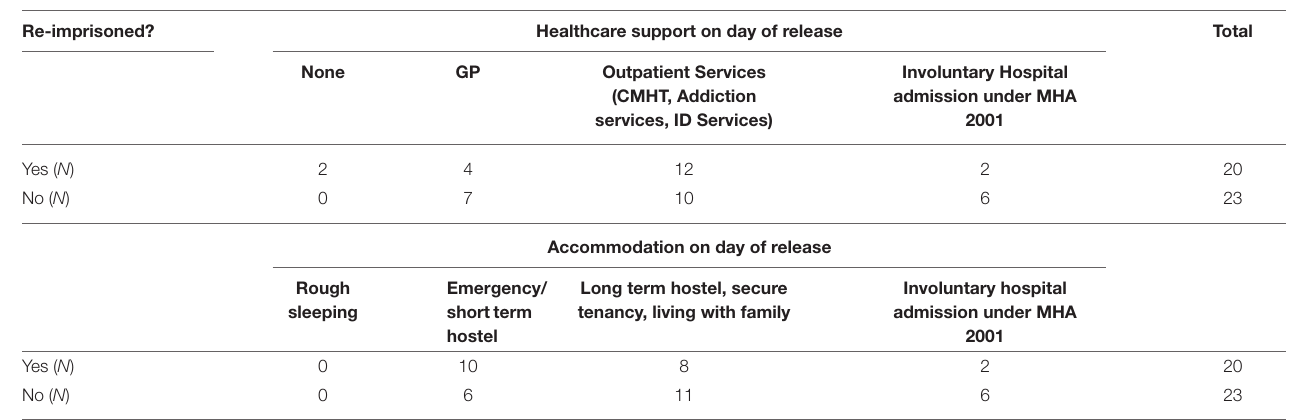
TABLE 6 | Impact of level of mental health support and accommodation outcomes on rates of re-imprisonment, following the intervention of the PReP Programme ( N = 43).